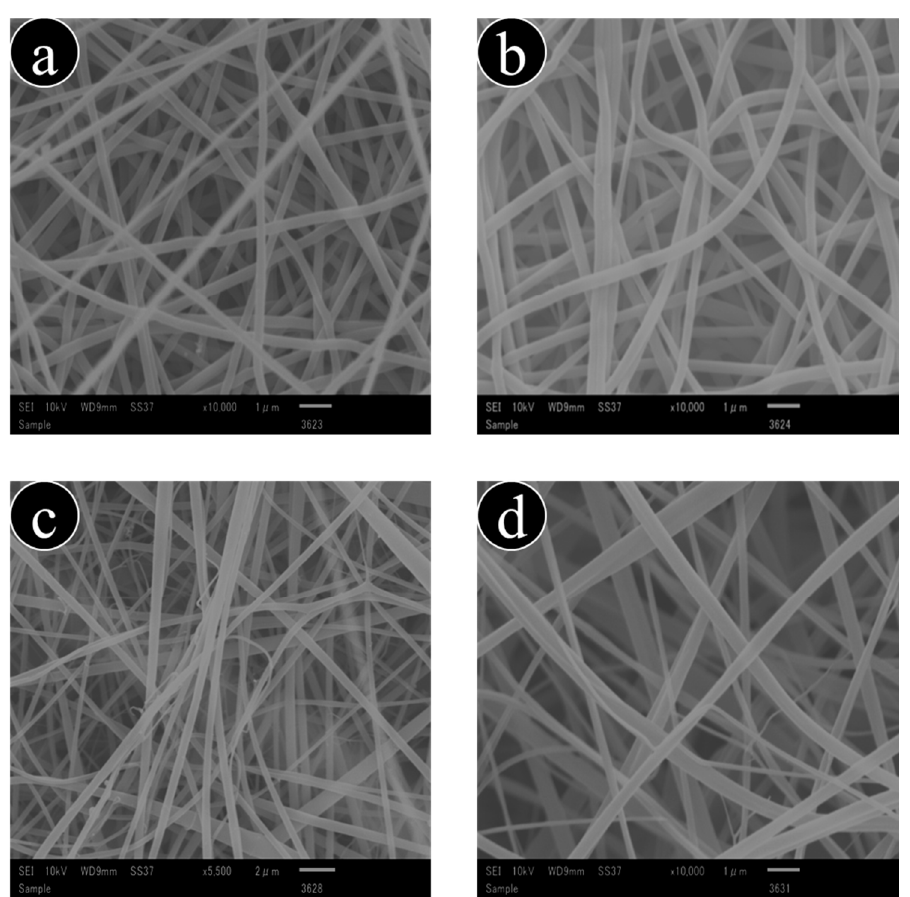
Figure 1. SEM images of nanofibers: ( a ) CA, ( b ) CA/Ceftriaxone, ( c ) PVA, and ( d ) PVA/Ceftriaxone.